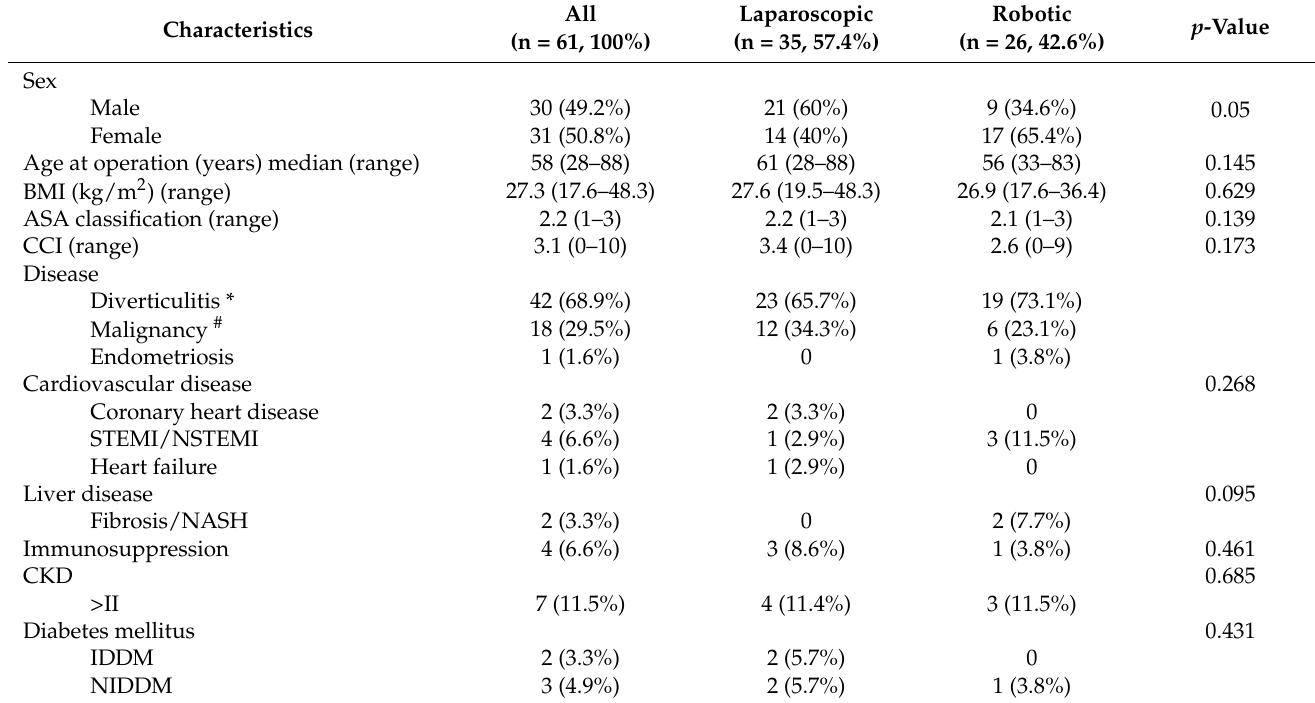
Table 1. Patient